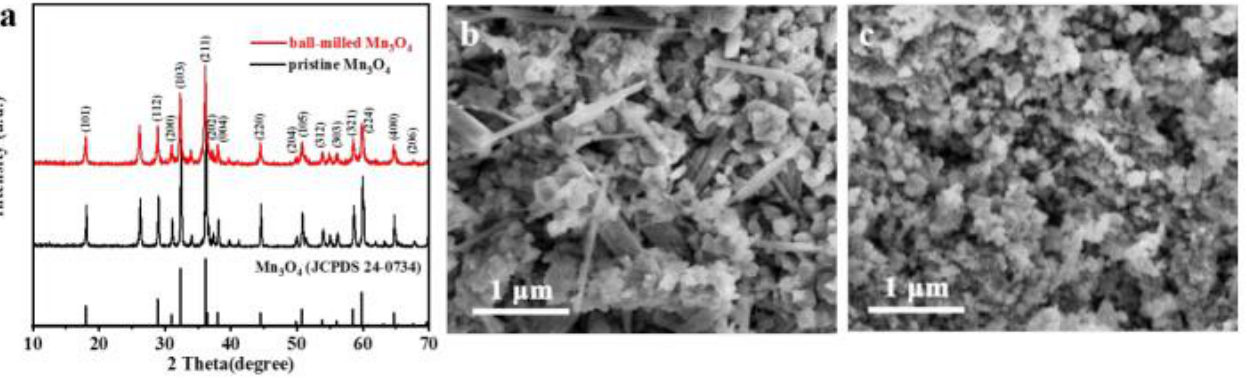
Figure 2. Illustration of the Mn 3 O 4 characterization process. ( a ) XRD patterns, ( b ) SEM image of the precursor Mn 3 O 4 , and ( c ) of the ball-milled Mn 3 O 4 , respectively. Reprinted with permission from [36]. Copyright 2018 American Chemical Society .